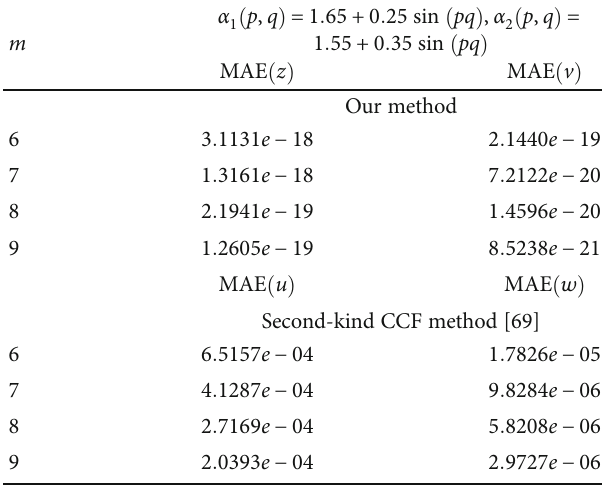
Table 11: The absolute error for di ff erent values m for Example 10 at various points ð p , q Þ .